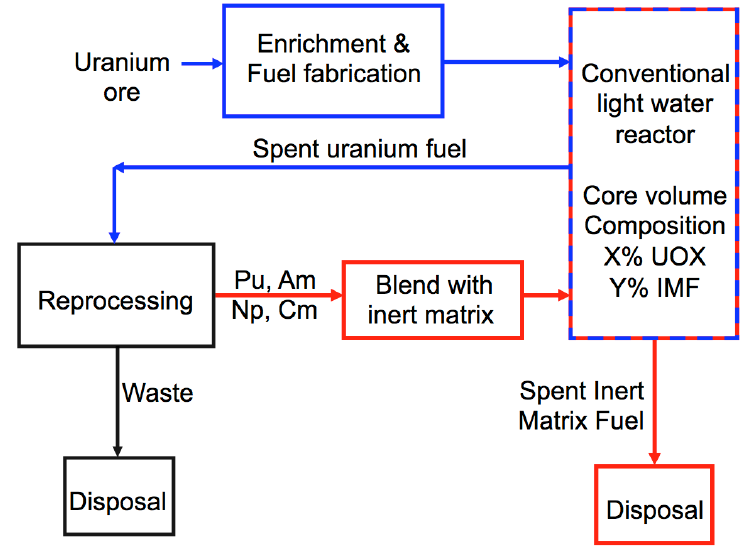
Figure 1. The inert matrix fuel cycle. Spent fuel from a conventional light-water reactor would be reprocessed and the transuranics Am, Cm, Np and Pu stripped, and blended with a uranium free matrix. The resulting fuel would be placed back into the light-water reactor. Because it contains no uranium, the inert matrix fuel form allows for the consumption of transuranic waste without any additional production. The inert matrix fuel would also reduce the overall amount of uranium in the core. The percentage of the core that is uranium dioxide (UOX) or inert matrix fuel (IMF) is a design